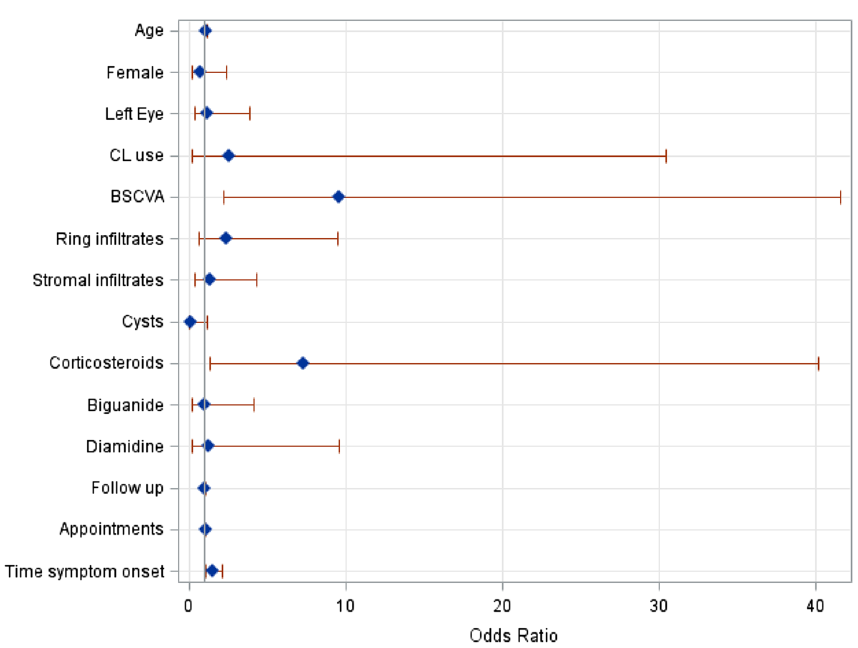
Figure 3. OR for the risk factors for poor